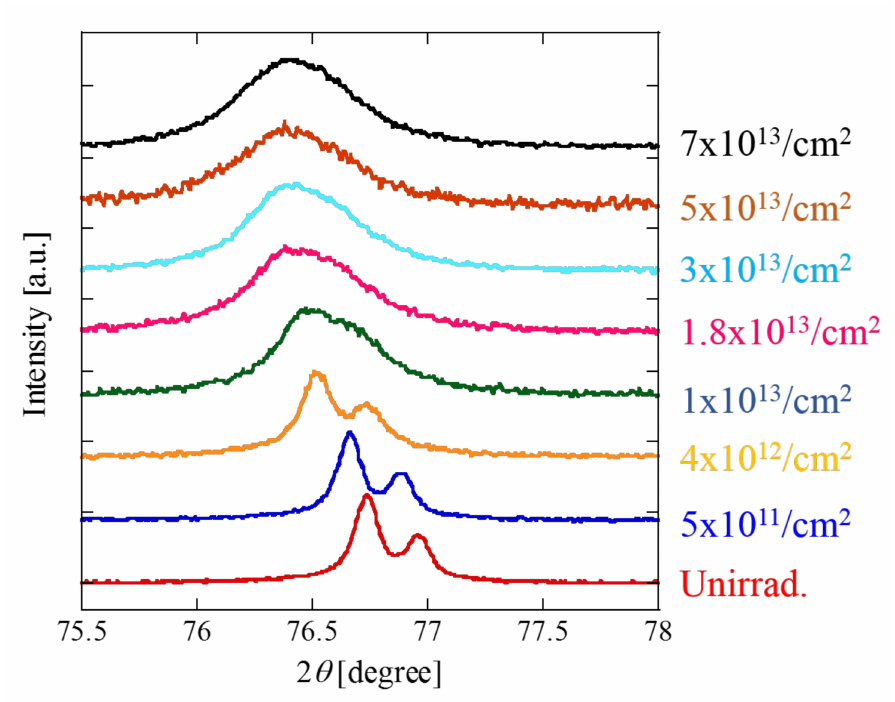
Figure 2. (331) XRD peaks for unirradiated and irradiated CeO 2 specimens. Xe ion fluences are shown at the right side of the